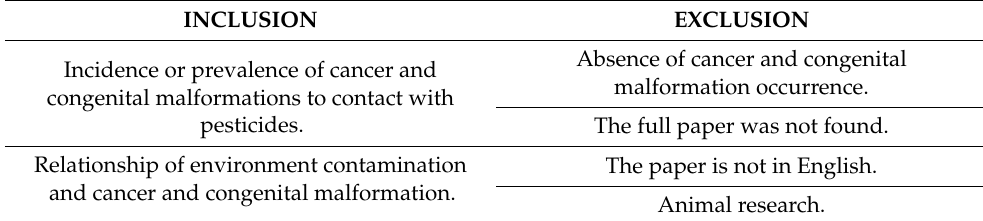
Absence of cancer and congenital malformation occurrence. The full paper was not found.